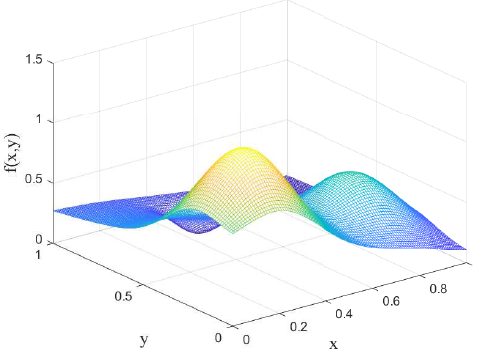
Figure 10. Franke’s test function on [ 0,1 ] × [ 0,1 ] .